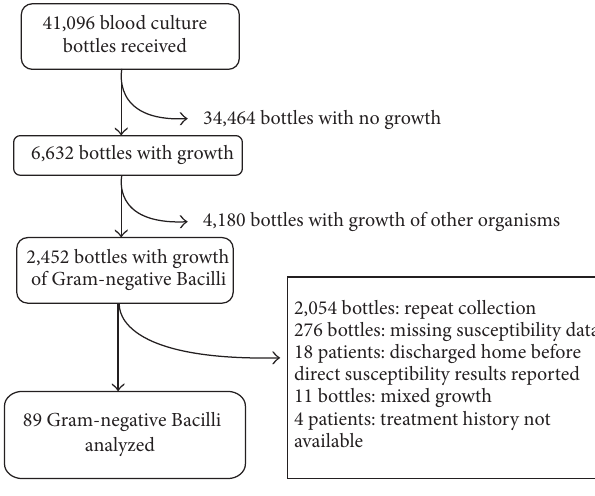
Figure 1: Specimen